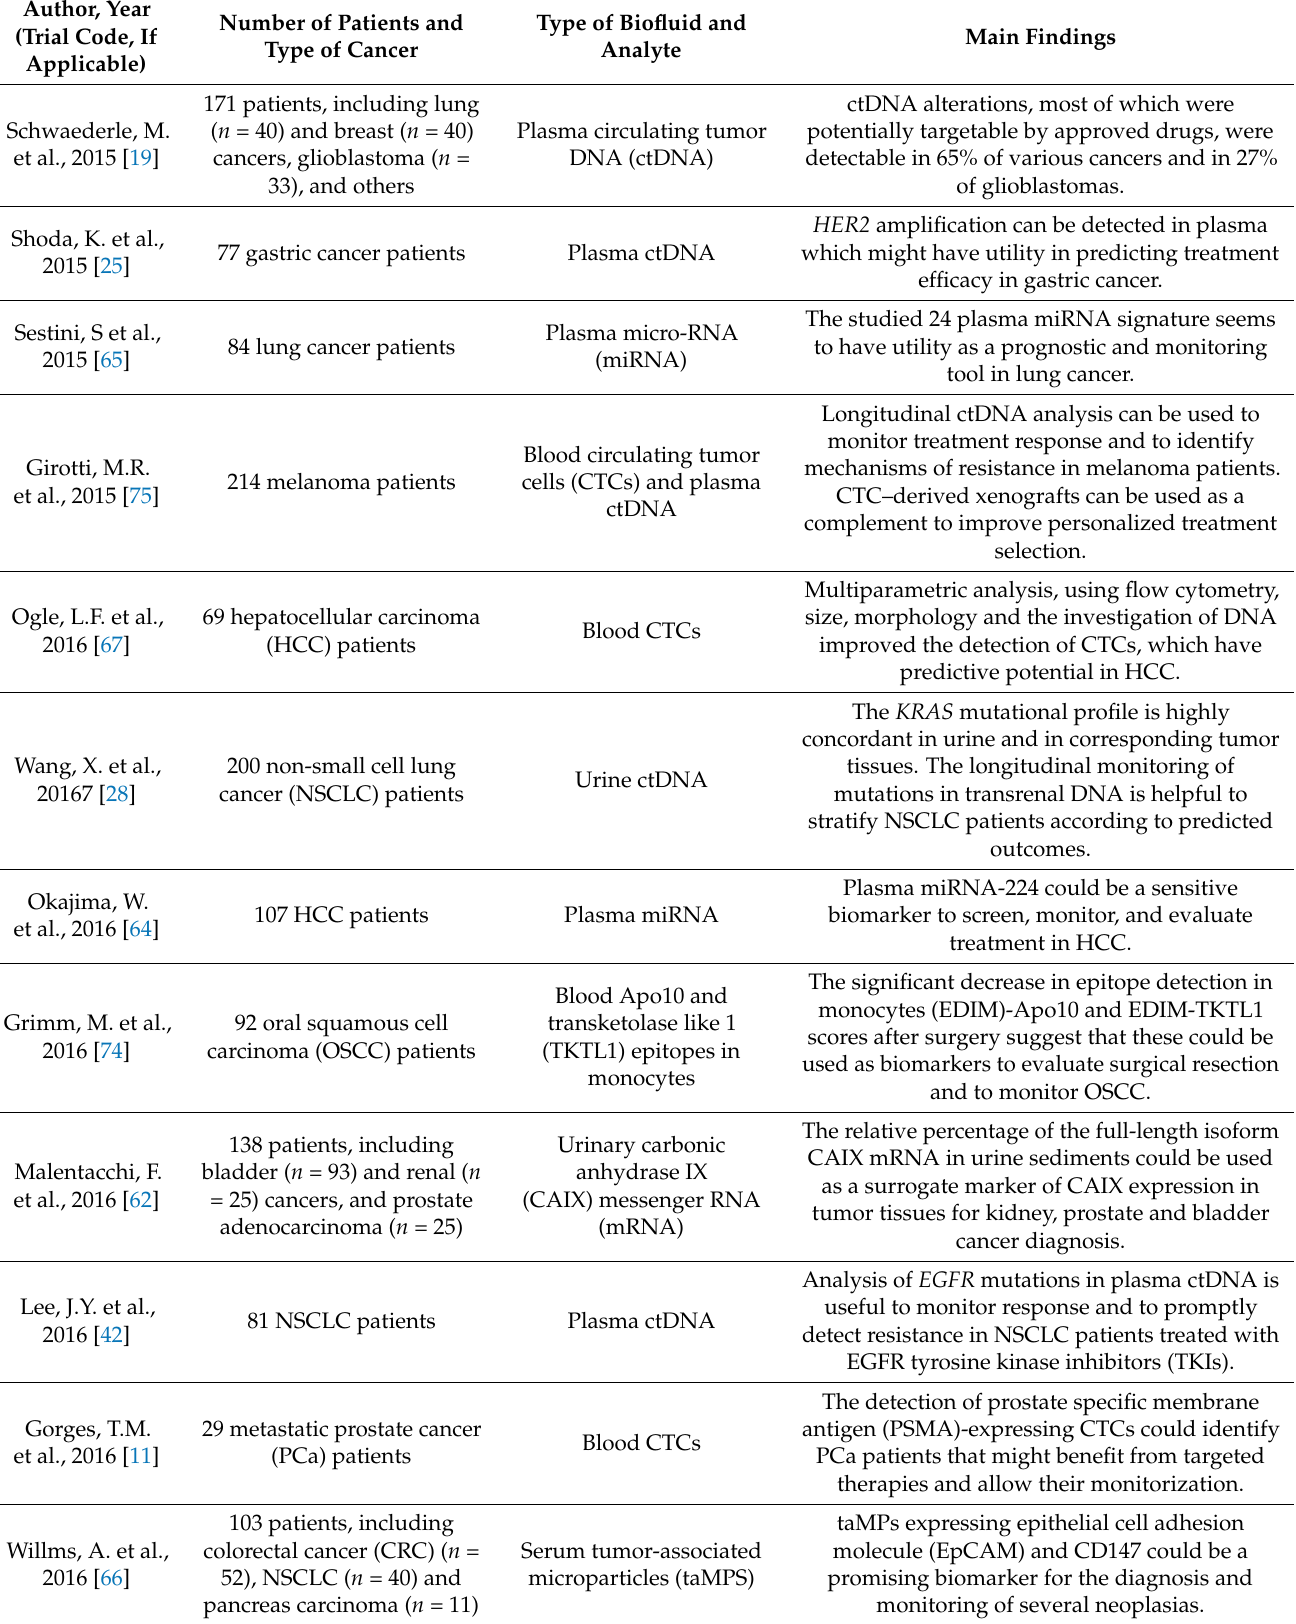
Table 1. Overview of the studies included in the